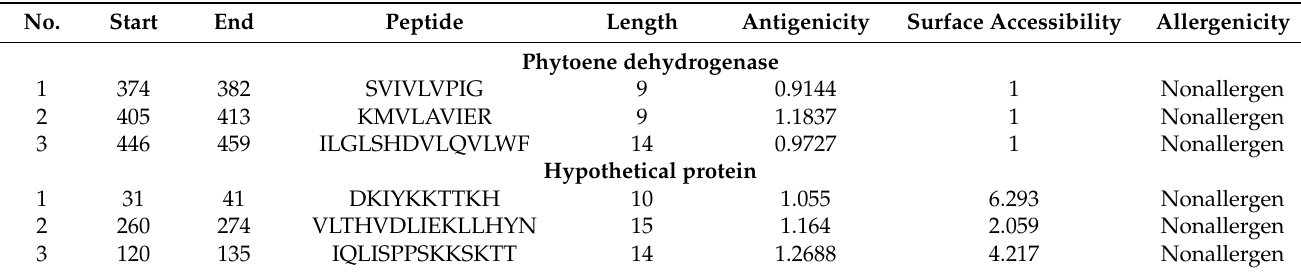
Table 2. Finalized B-cell epitopes for the vaccine